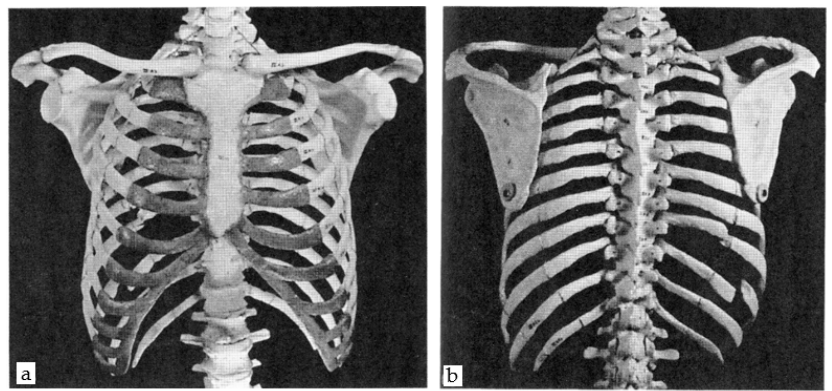
Figure 1. The frontal ( a ) and dorsal ( b ) view of the human thorax.